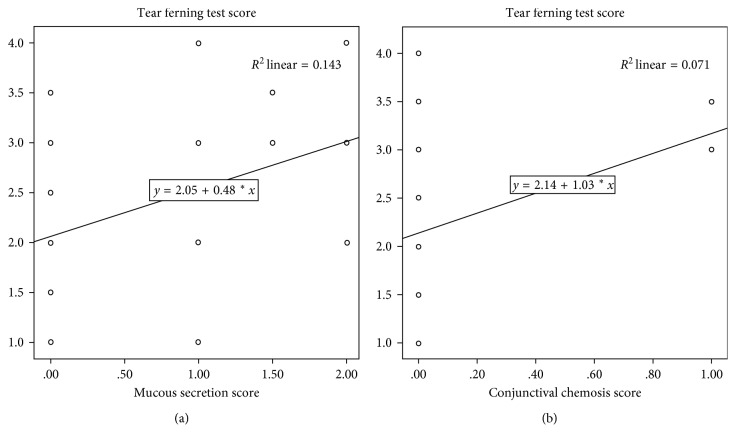
The tear ferning test (TFT) score shows direct correlation with mucous secretion severity (p=0.004, R = 0.373) (a) and conjunctival chemosis (p=0.031, R = 0.278) (b), indicating altered quality of the lacrimal mucous component.